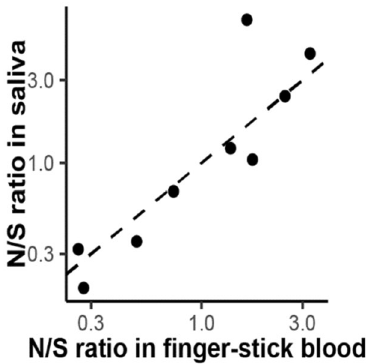
Figure 5. Relative reactivity to the CoV-2 nucleocapsid (N) and spike (S) antigens measured in finger-stick blood and saliva from subjects whose levels of anti-spike IgG exceeded the threshold. The ratio of IgG levels to the N and S antigens (N/S ratio) ranged from 0.12 to 4.3 , and was highly correlated in matched finger-stick blood and saliva provided by the same donors (Spearman coefficient = 0.95, p = 0.001). The dashed line has slope of 1 and represents the expected correlation.